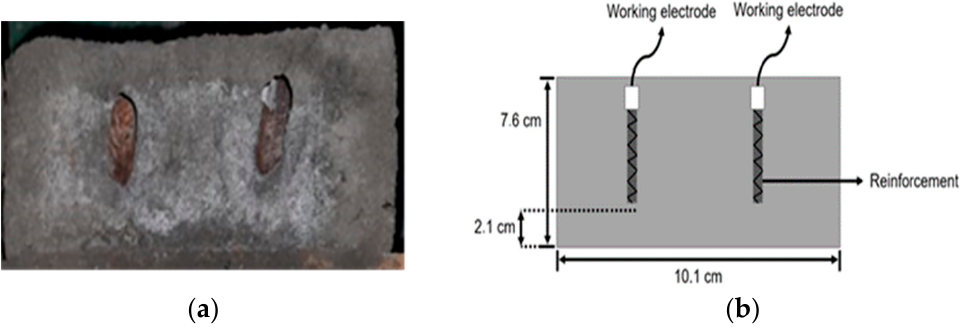
Figure 1. Reinforced concrete used in determining the effect of porosity and its correlation with degradation: ( a ) sample; ( b ) schematic.